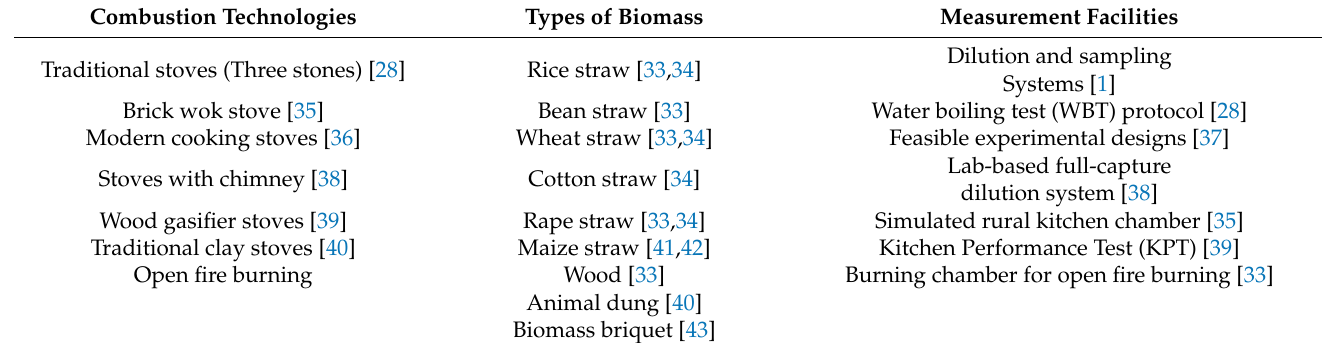
Table 1. Combustion technologies, biomasses, and measurement facilities in studies.